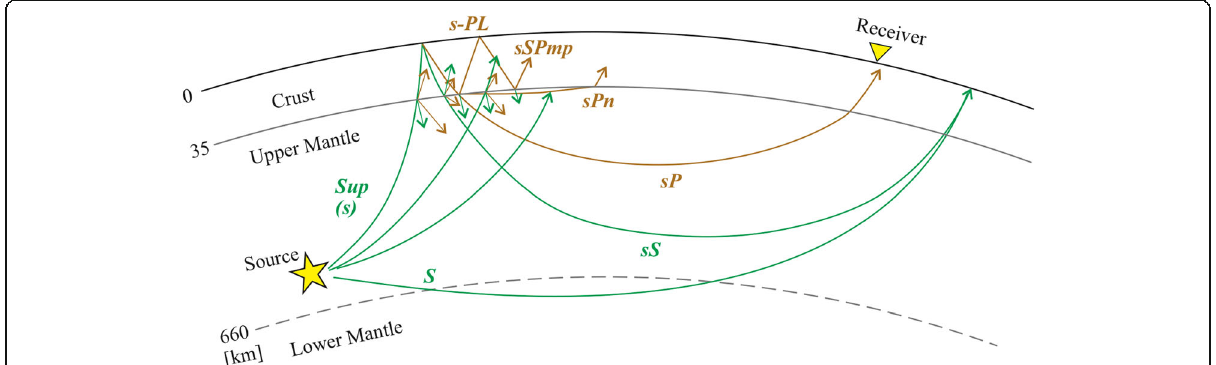
Fig. 3 Schematic illustration of the raypaths for major seismic phases from a very deep source: upgoing S wave ( Sup , s), downgoing S wave, surface reflected sS and sP, sPn waves and multiple sSPmp reflections in the crust are marked. Horizontally travelling sSPmp multiples in the crust couple with the incoming S wave (s) develop the s-PL